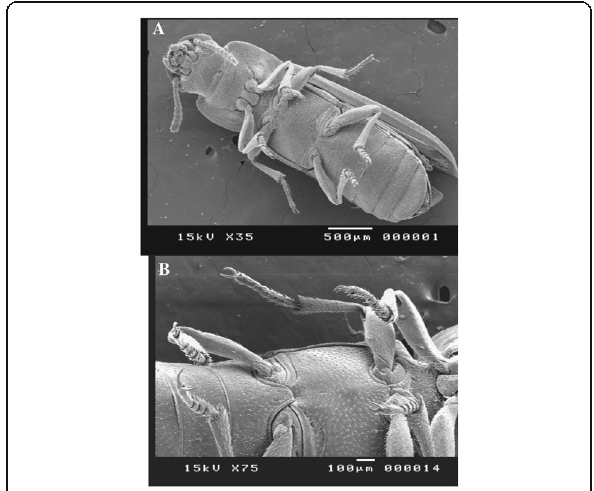
Fig. 1 a SEM micrograph of the adult of T. confusum . b Higher